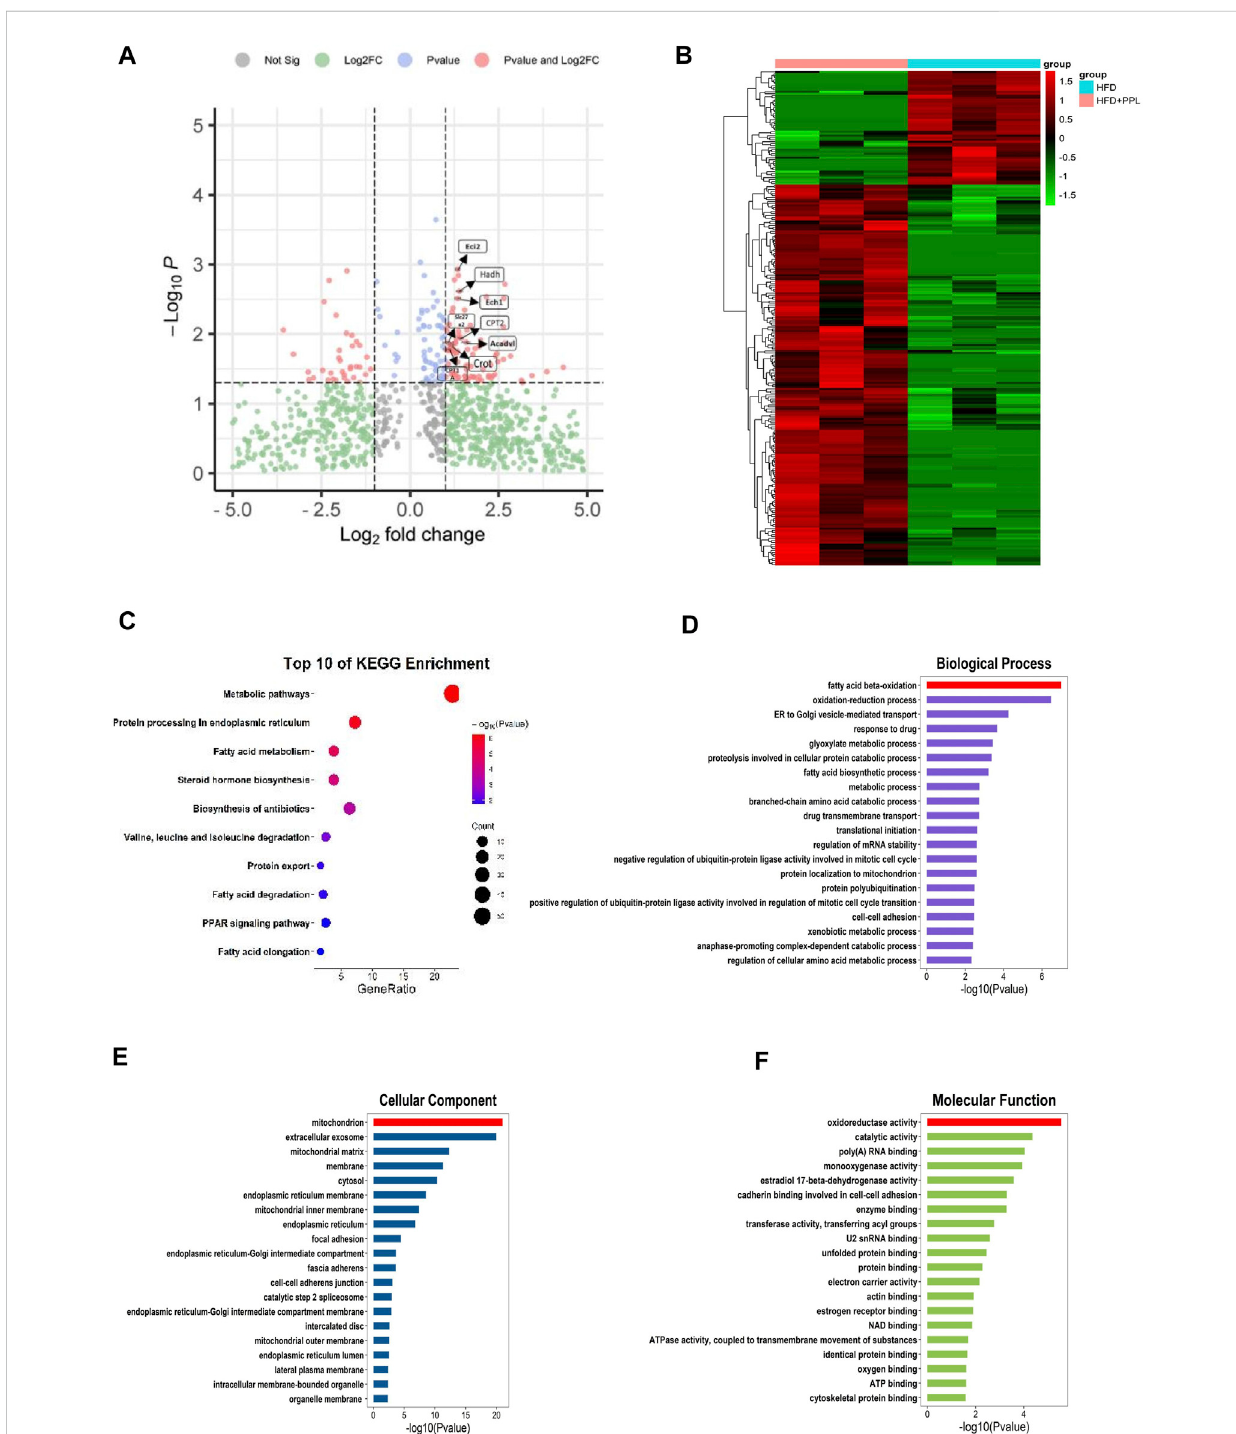
FIGURE 3 Proteomic analyses of liver specimens from differentially expressed proteins of HFD and HFD + PPL (400 mg/kg) group. (A) Amount of differentially expressedproteins(HFD+PPL/HFD).Upregulated,Foldchange ≥ 1.5;downregulated,Foldchange ≤ 0.667.FAO-relatedproteinswerelabeled. (B) Cluster heat map of differentially expressed proteins from HFD and HFD + PPL group. (C) KEGG enrichment analysis of hepatic differentially expression of proteins. (D – F) Biologicalprocess,Molecular